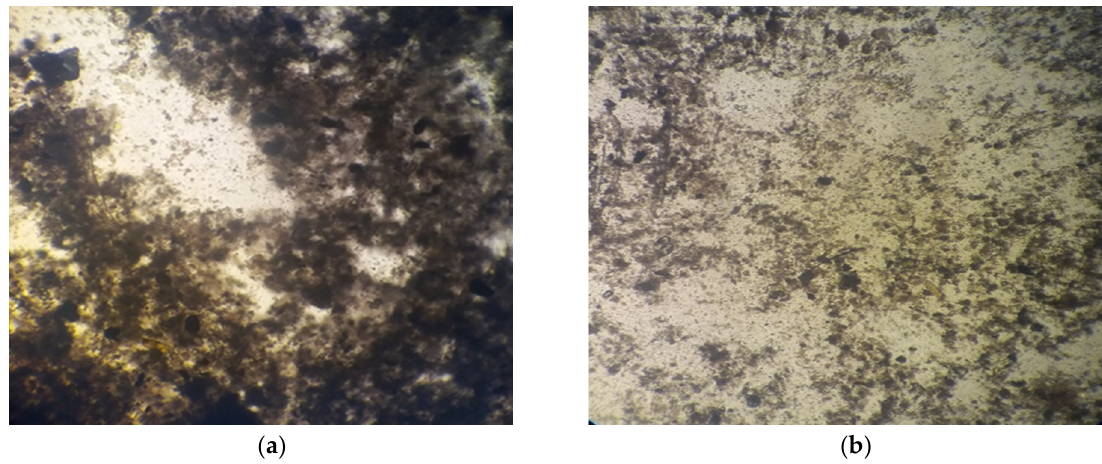
Figure 4. Structure of the initial mixture of primary sediments and activated sludge ( a ) and after MW treatment ( b ).